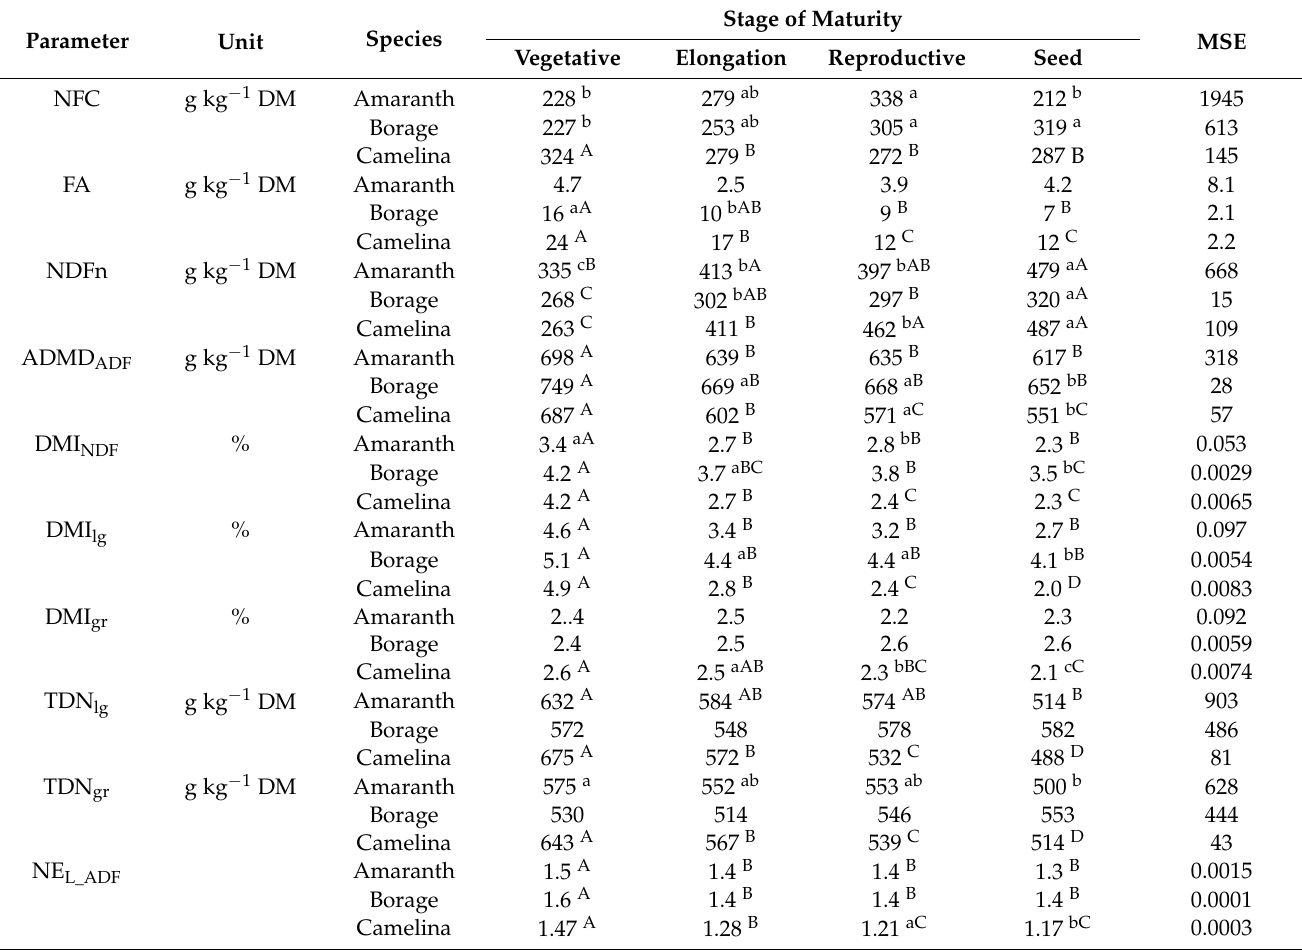
Table 4. Lsmean and mean square of error (MSE) of the calculated parameters at the vegetative, elongation, reproductive, and seed stages (Amaranth DFE = 10; Borage DFE = 6; Camelina DFE = 11), when using the formulae for legumes ( lg ) and grasses ( gr